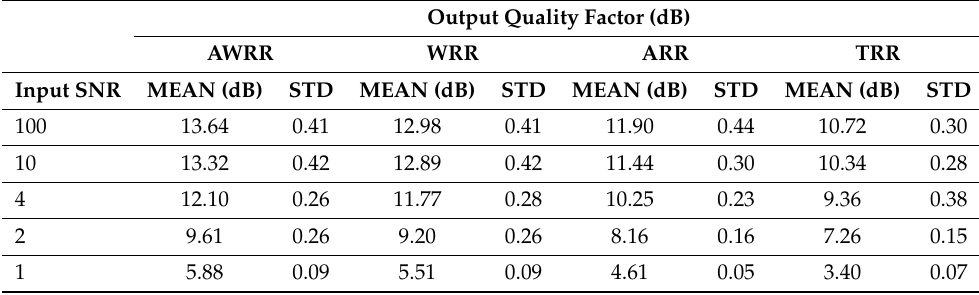
Table 2. Mean and standard deviation of the quality of interpolation for each method for different SNR